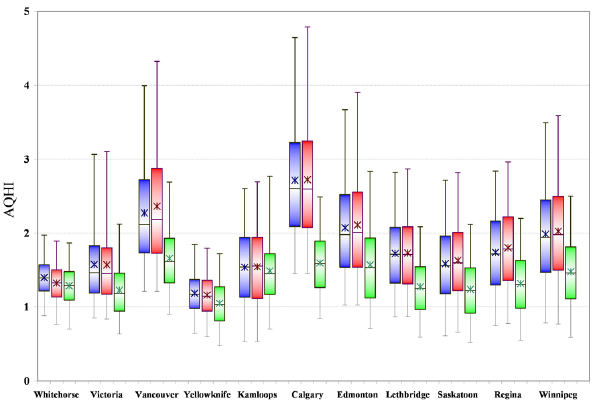
Fig. 11. Air Quality Health Index box-and-whisker histograms, western Canadian towns and cities. Blue: “Current”. Red: CC. Green: CE. Upper and lower whisker limits are 98th and 2nd per- centiles, respectively, box limits are 75th and 25th percentile, me- dian is solid horizontal bar, mean is * symbol.